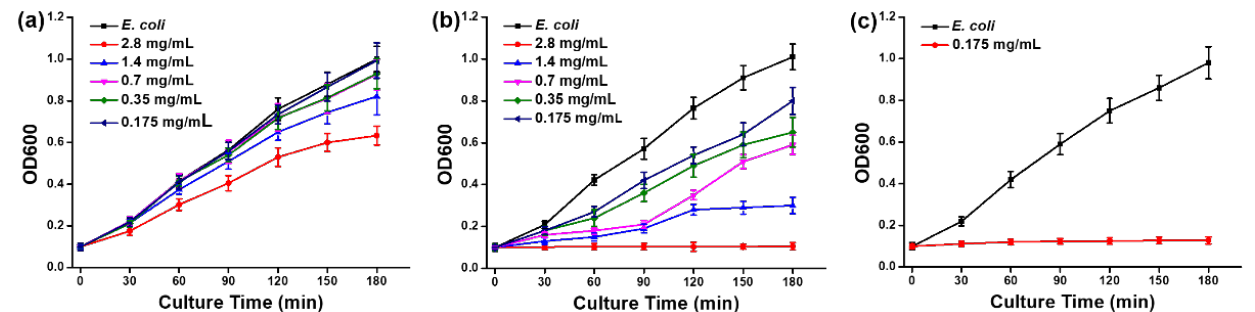
Figure 4. Growth curves of the E. coli incubated with ( a ) Cys–AuNCs, ( b ) Cys–AgNCs, and ( c ) AgNPs. OD600 indicates the optical density of a sample measured at a wavelength of 600 nm. All data are presented as means ± SD, n = 3 per group.